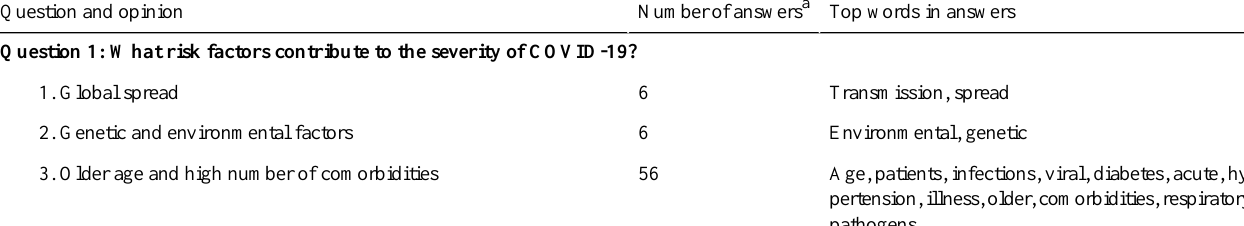
Table 2. Opinions, the number of answers supporting every question, and the words with the highest frequency for each opinion in articles published since 2019. Question 1: What risk factors contribute to the severity of COVID-19?